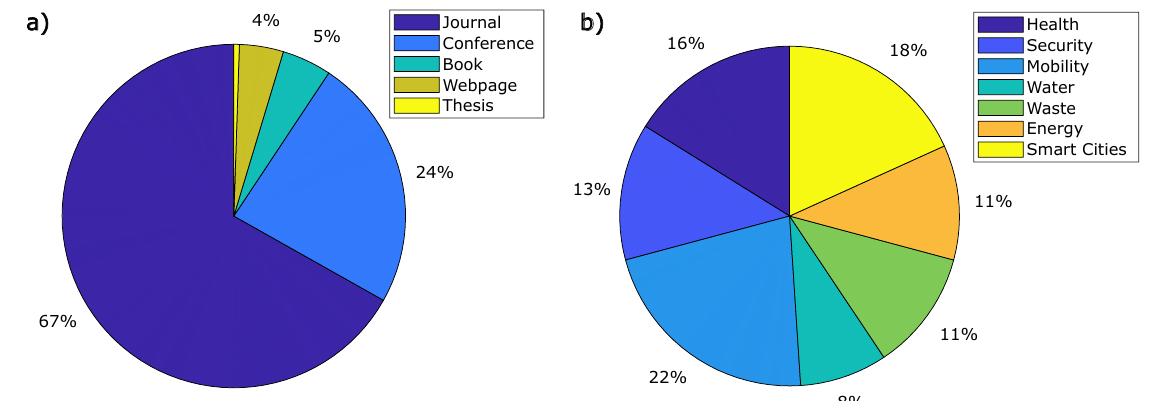
Figure 2. Pie charts representing the distribution of the ( a ) Type of reference and ( b ) Topic of the selected references for this